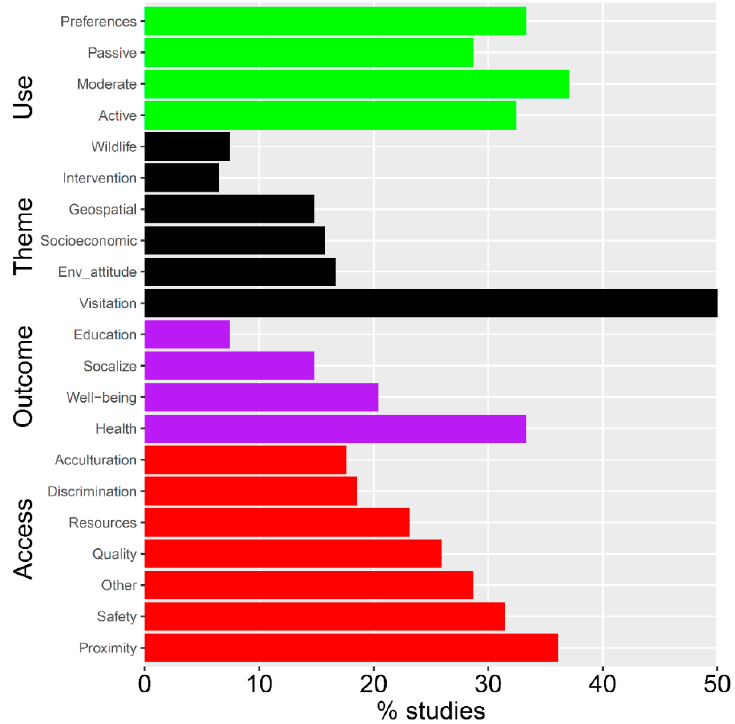
Figure 3. Representation of research topics across all 108 studies, grouped by broad categories (color groups). The broad categories are Use (green bars) that describe how visitors or participants used park or outdoor resources, Theme (black) that represent the general approach of the study, Outcomes (purple) that reflect measured responses or outcomes to participation in outdoor or nature-based activities, and Access (red) that depict barriers to participation or use.